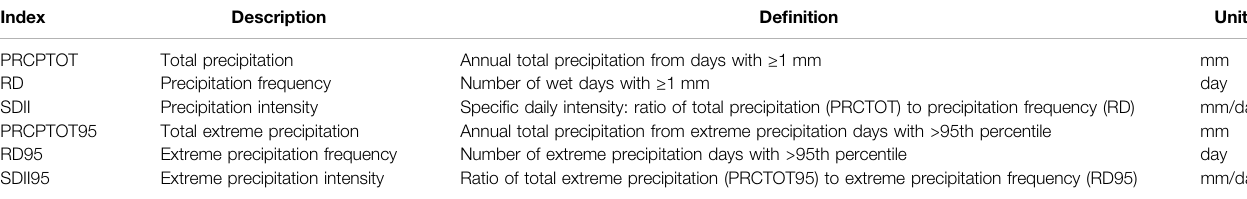
TABLE 1 | Precipitation indices and de fi nitions recommended by the Expert Team on Climate Change Detection and Indices.